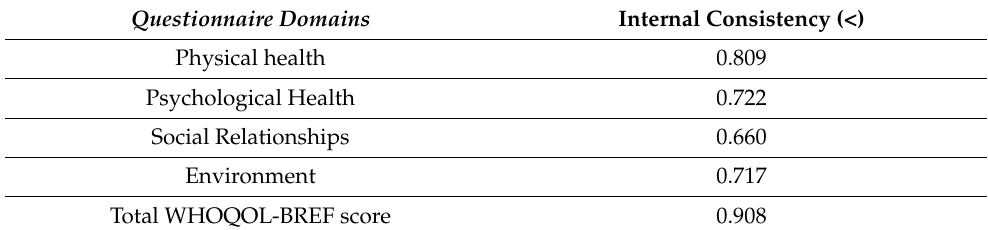
Table 5. Results of the item–test correlation and internal